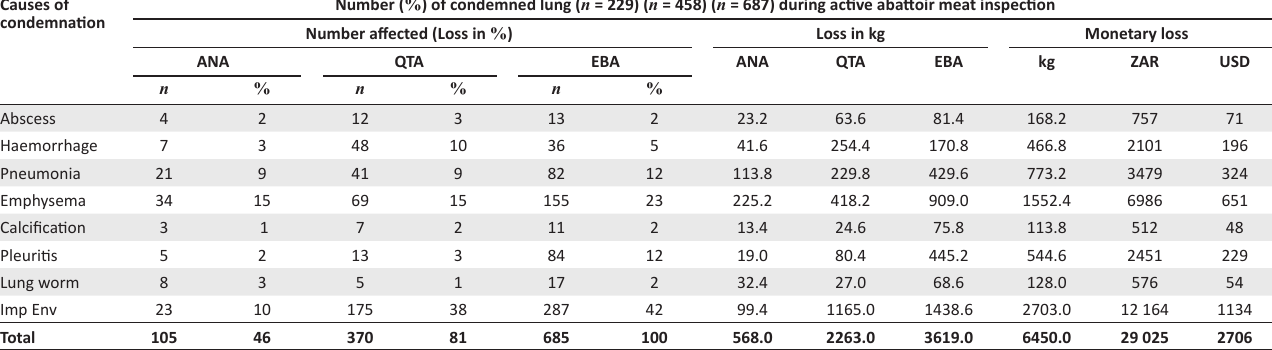
TABLE 3: Conditions that led to the condemnation of lung and associated monetary loss (in ZAR) during the active abattoir survey (July–December 2013). Causes of